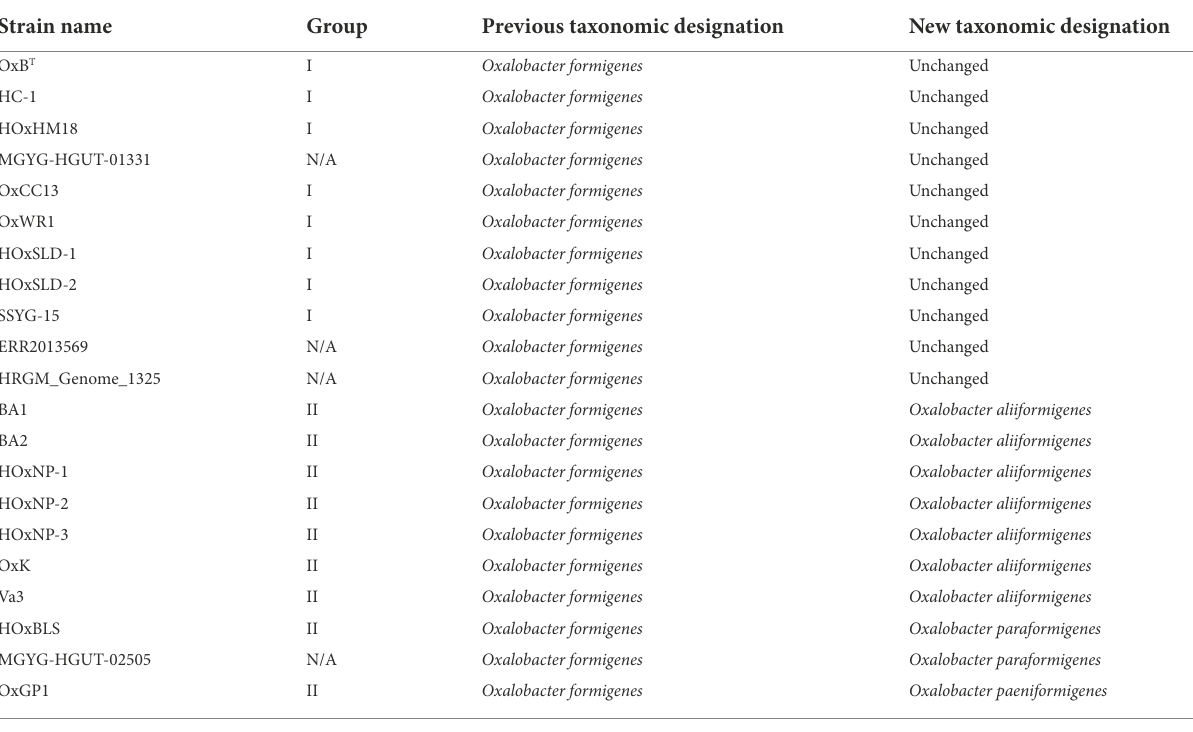
TABLE 1 New taxonomic designations of Oxalobacter formigenes